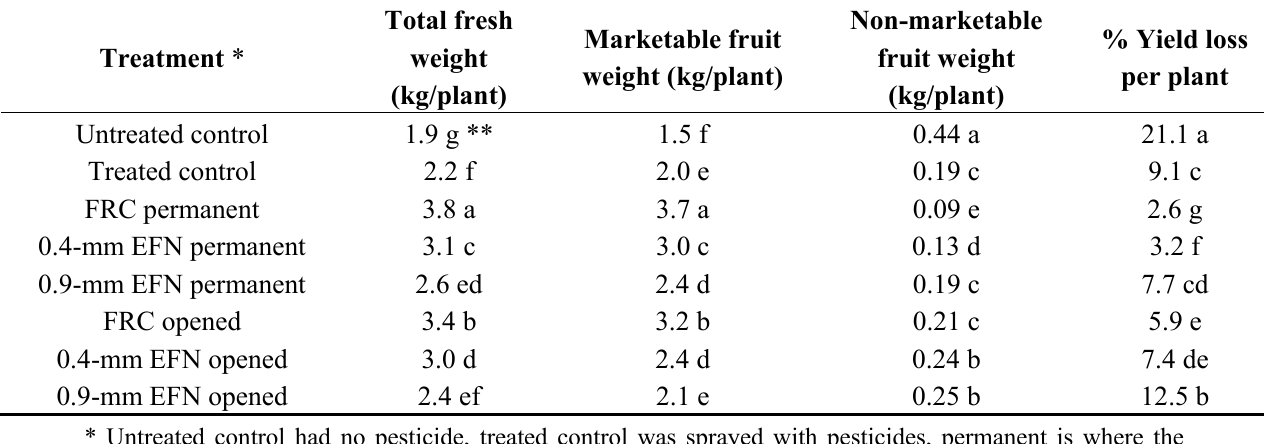
Table 3. Effects of floating row covers (FRC) and eco-friendly nets (EFN) on tomato yield (kg/plant) during production. Values are averages of two growing seasons (May to October 2011 and October 2011 to March